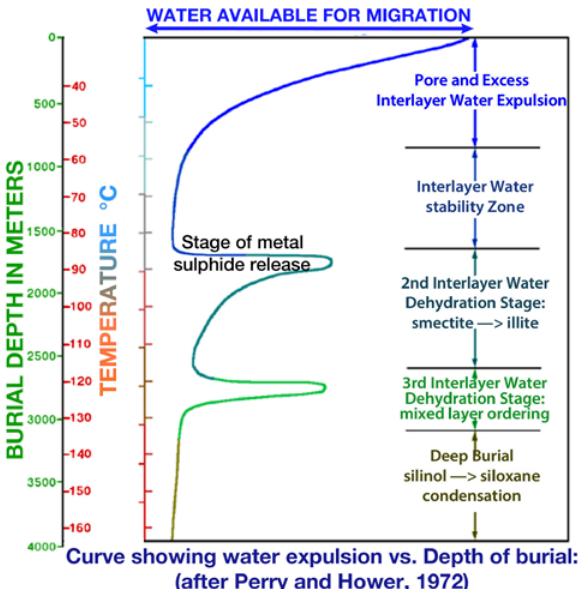
Figure 76: Some 3 tons of water must seep out of sediments for every ton of rock formed by their long slow compaction and crys- tallisation (Ref.